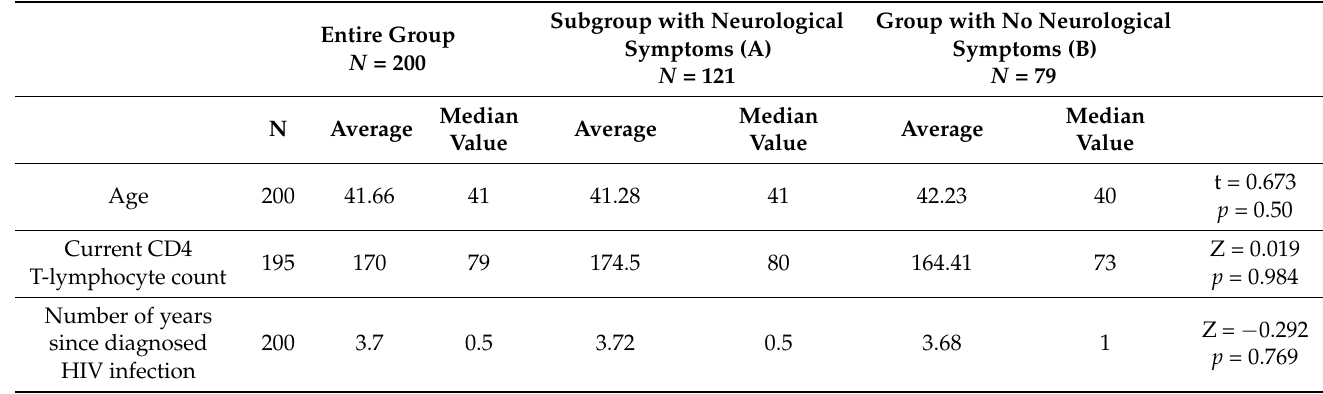
Table 2. Age and time from detection of infection in individual patient subgroups.